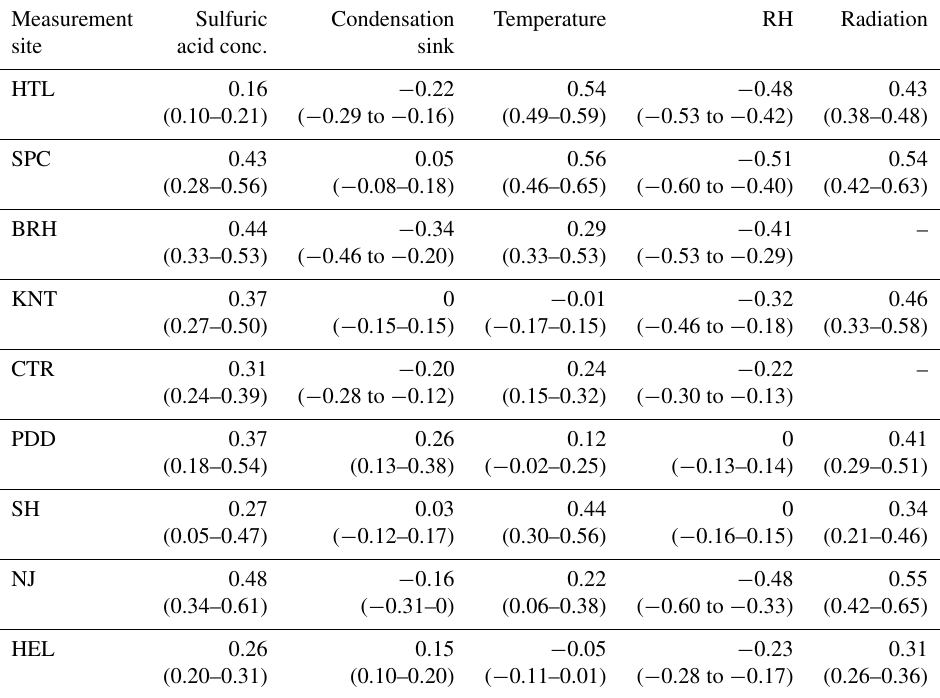
Table 5. Pearson’s correlation coefficients between sub-3nm particle concentration and other variables at different measurement sites. The confidence intervals for the coefficients (the 95% confidence level) are shown in parentheses.